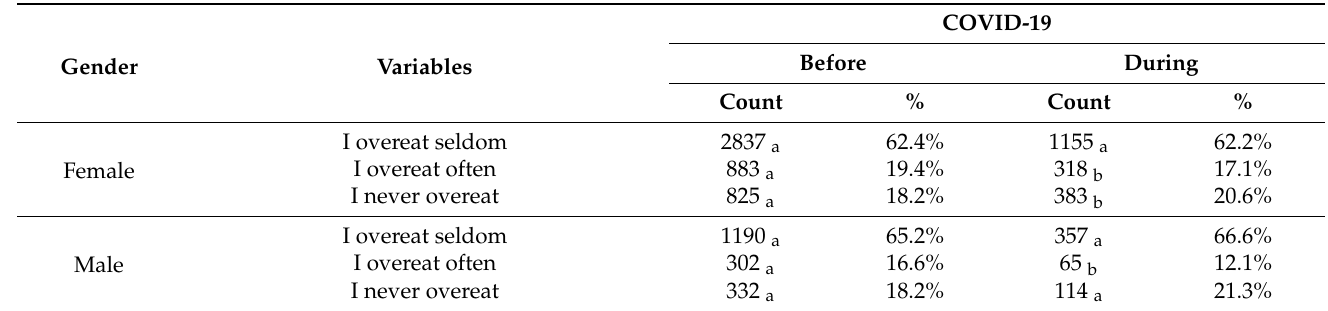
Table 3. Overeating behavior before and during COVID-19.